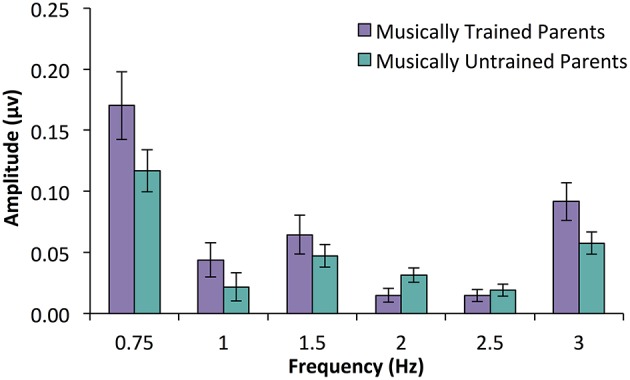
SS-EP amplitudes (noise subtracted, averaged across all channels) across frequencies of interest for 15-month-old infants who have parents with ≥5 years of combined music training (n = 16, musically trained parents) and infants with < 5 years of combined parent music training (n = 17, musically untrained parents). Infants with musically trained parents have larger peaks across SS-EP frequencies compared to infants without musically trained parents, p = 0.037.